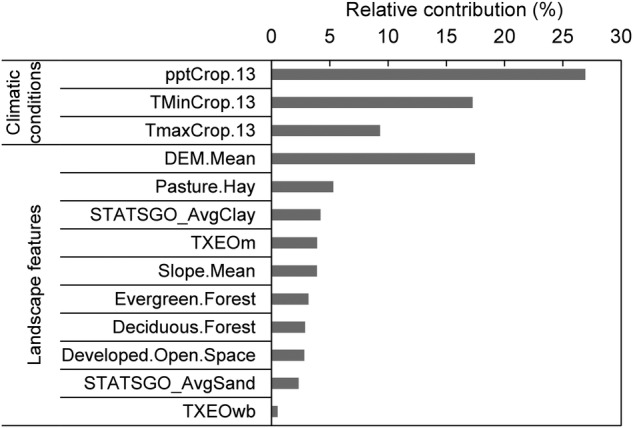
Relative contributions (%) of the 13 most influential variables included in the final model (see Table 1 for the description of variables).